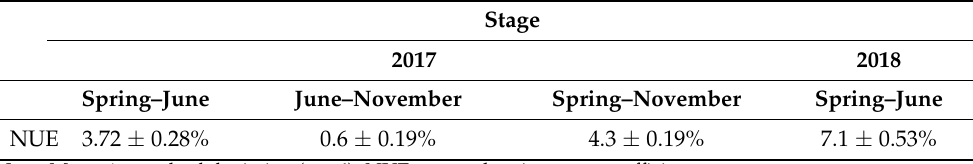
Figure 1. The ratio of fertilizer nitrogen uptake of each organ to the total fertilizer nitrogen uptake of all organs during various stages. ( A ) Spring to June 2017; ( C ) Spring to November 2017; ( D ) Spring to June 2018. ( B ) represents the ratio of fertilizer nitrogen uptake of each organ to the total fertilizer nitrogen uptake of all organs except for leaves from June to November 2017. Table 3. NUE in each growth stage of young pear